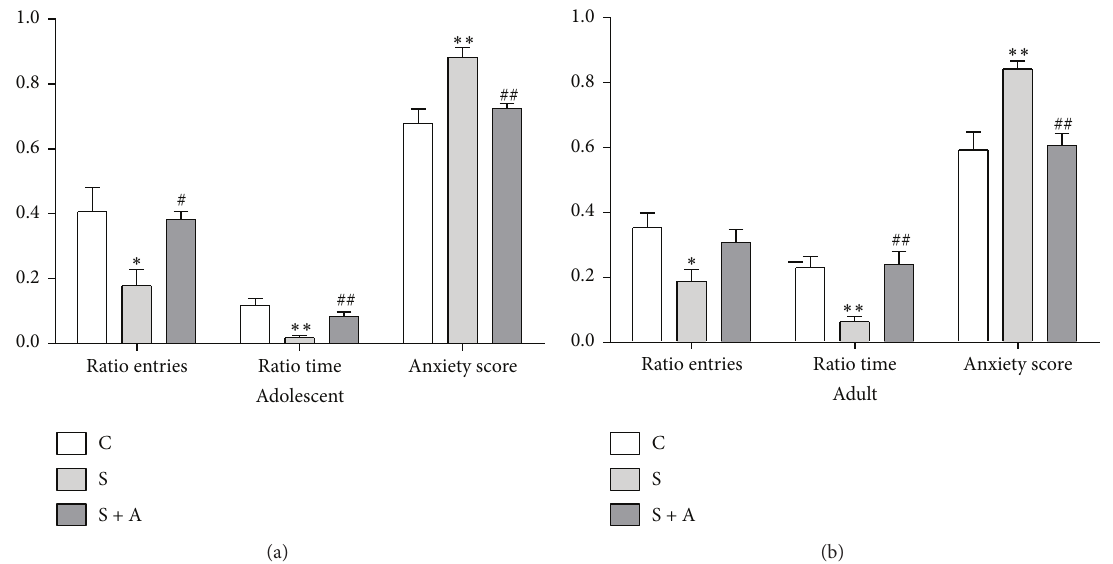
Figure 2: Anxiety-like behavior in the EPM test ( 𝑛 = 8 in each group). (a) Anxiety-like behavior of rats in the EPM test in adolescence. (b) Anxiety-like behavior of rats in the EPM test in adulthood. Ratio entry was defined as the total entries into the open arms divided by the total entries into any arm of the maze. Ratio time was defined as the total time spent in the open arms divided by the total time spent in any arm of the maze. Anxiety score was calculated as anxiety score = 1 − (ratio time + ratio entry/2). Values were expressed as mean ± SEM. ∗ and ∗∗ indicate 𝑝 < 0.05 and 𝑝 < 0.01 versus CON, respectively; # and ## indicate 𝑝 < 0.05 and 𝑝 < 0.01 versus S,